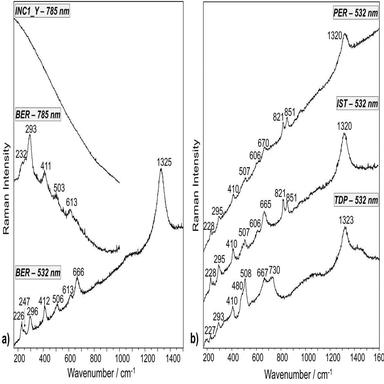
Representative Raman spectra acquired on different samples with 532 and 785 nm lasers.